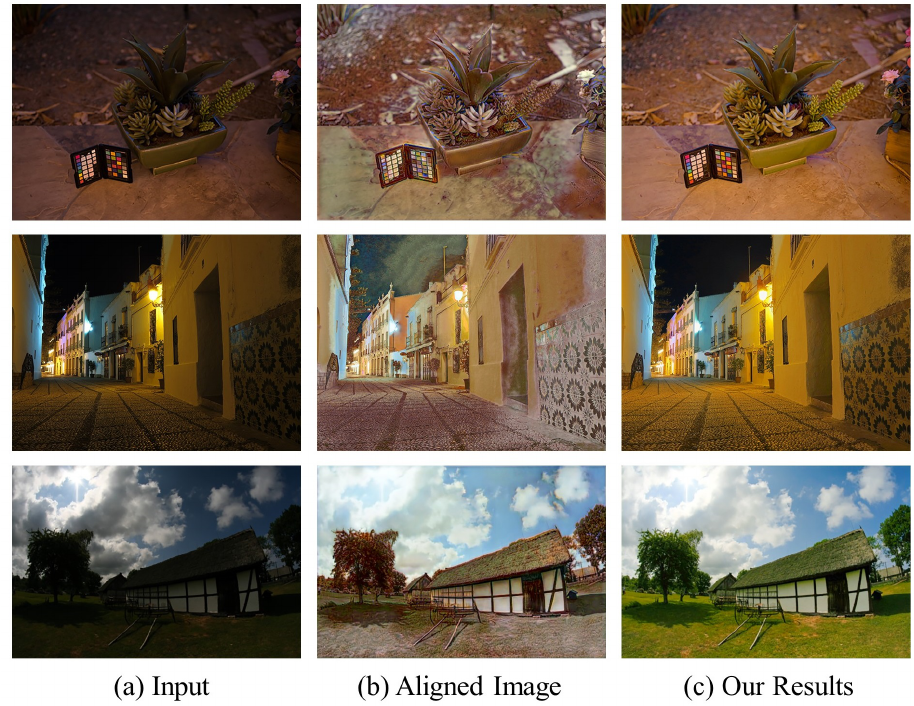
Figure 1. Examples of low-light image enhancement using our method. ( a ) Input low-light images. ( b ) The aligned images resulting from adaptive global photometric alignment improve the contrast and reveal underexposed regions. ( c ) The final results display rich detail and vibrant